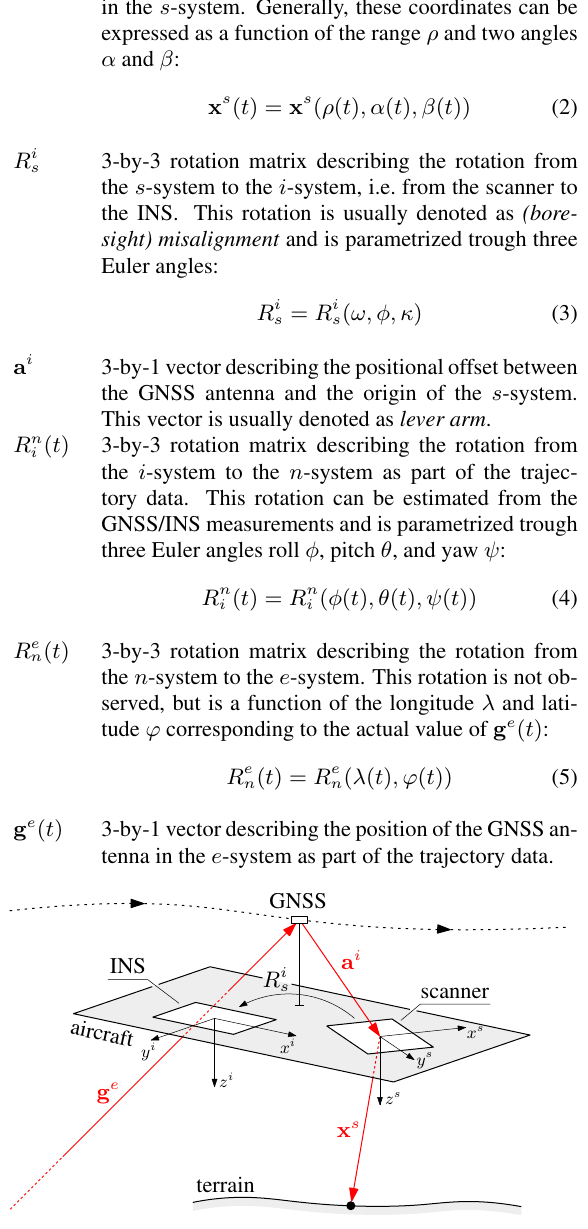
Figure 2: Direct georeferencing of ALS point